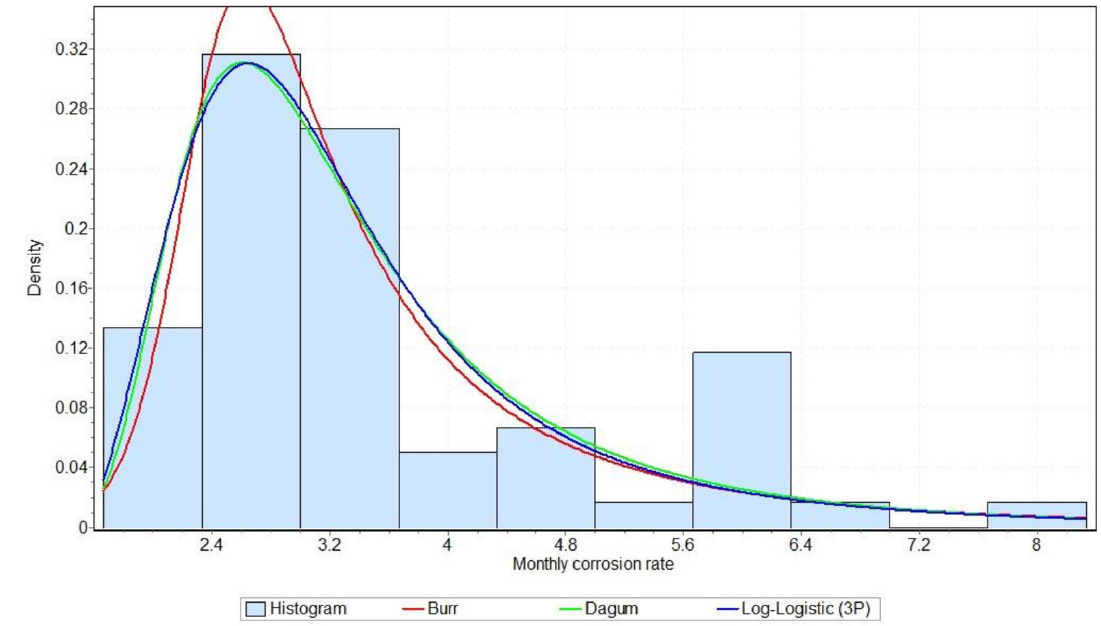
Figure 12. Empirical PDF and the three best fitted three-parameter distributions of NiTi-1 alloy corrosion rate in a tide